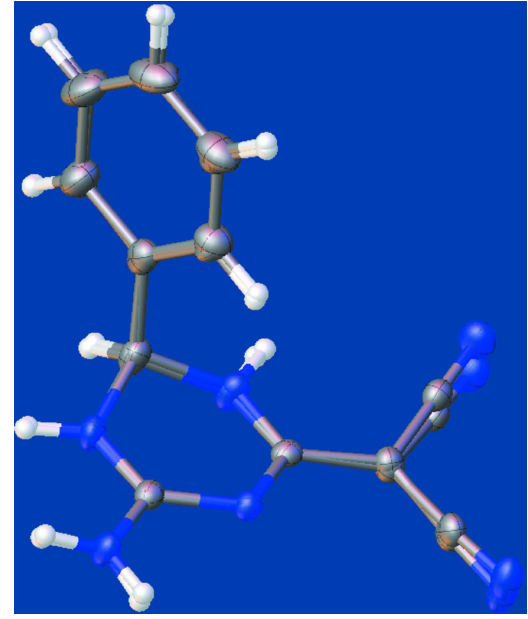
(Table 1) through the solvent dimethylformamide molecule